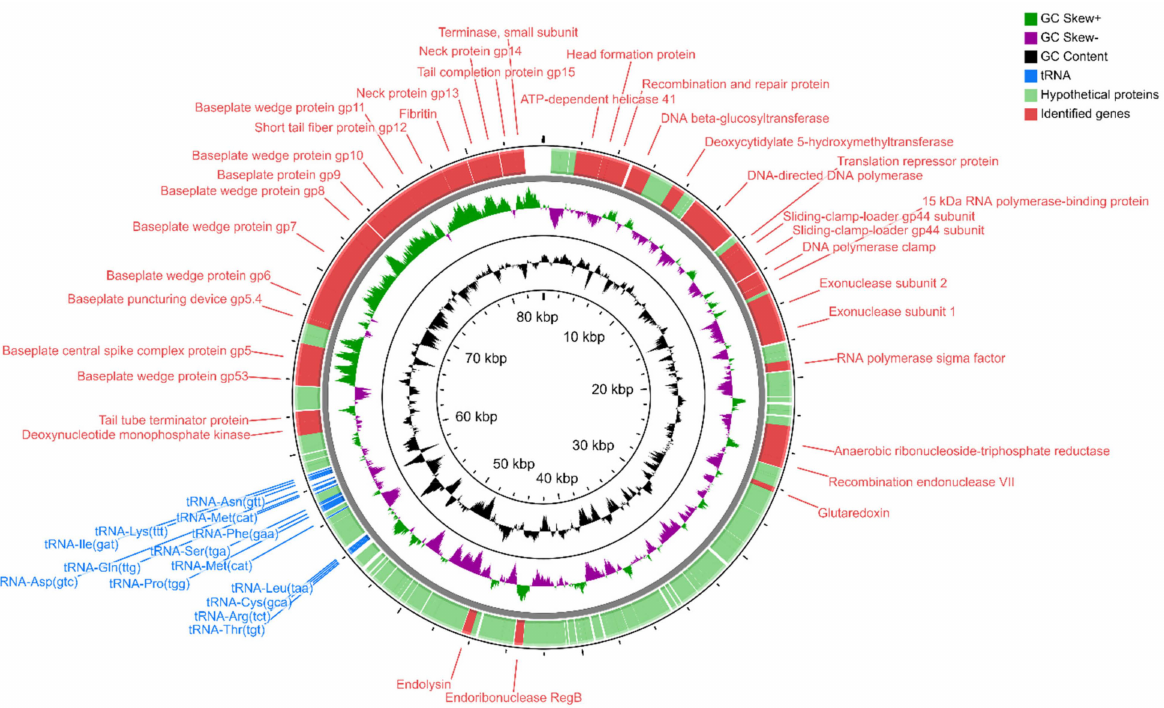
Figure 10. Map of the genome organization of Enterobacter phage KKP 3262 generated by using the CGView program